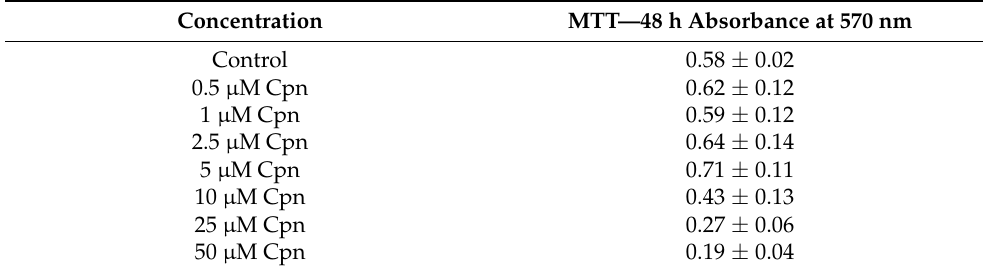
Table 3. MTT assay at 48 h following cordycepin treatment of DPSC.